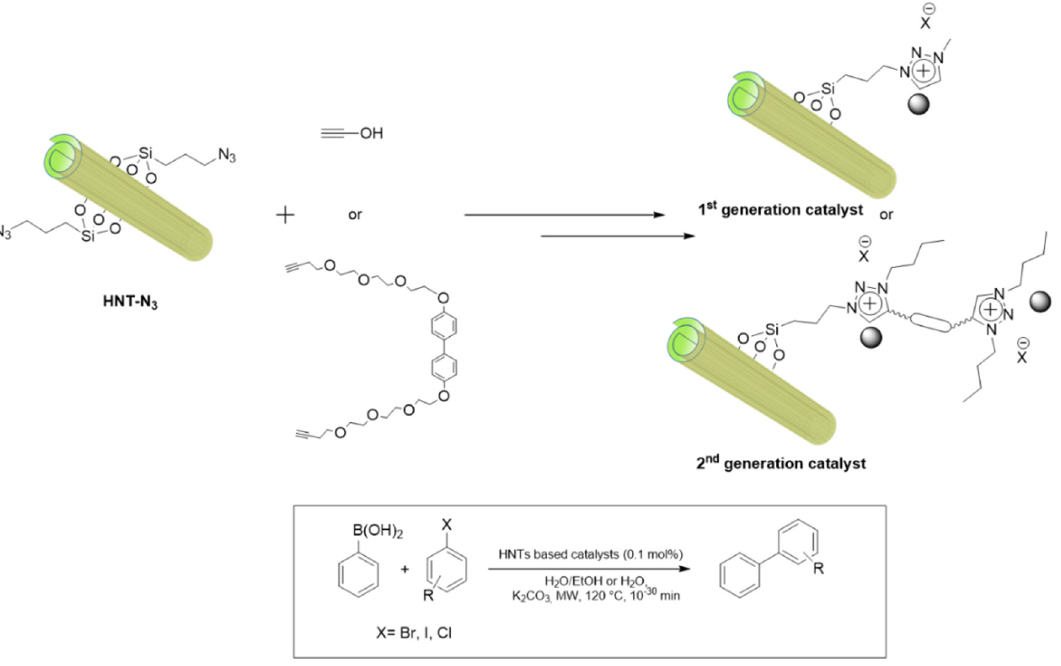
Figure 13. Synthesis of the 1st and 2nd generation HNTs triazolium salt ‐ based catalysts and their application in the Suzuki reaction.